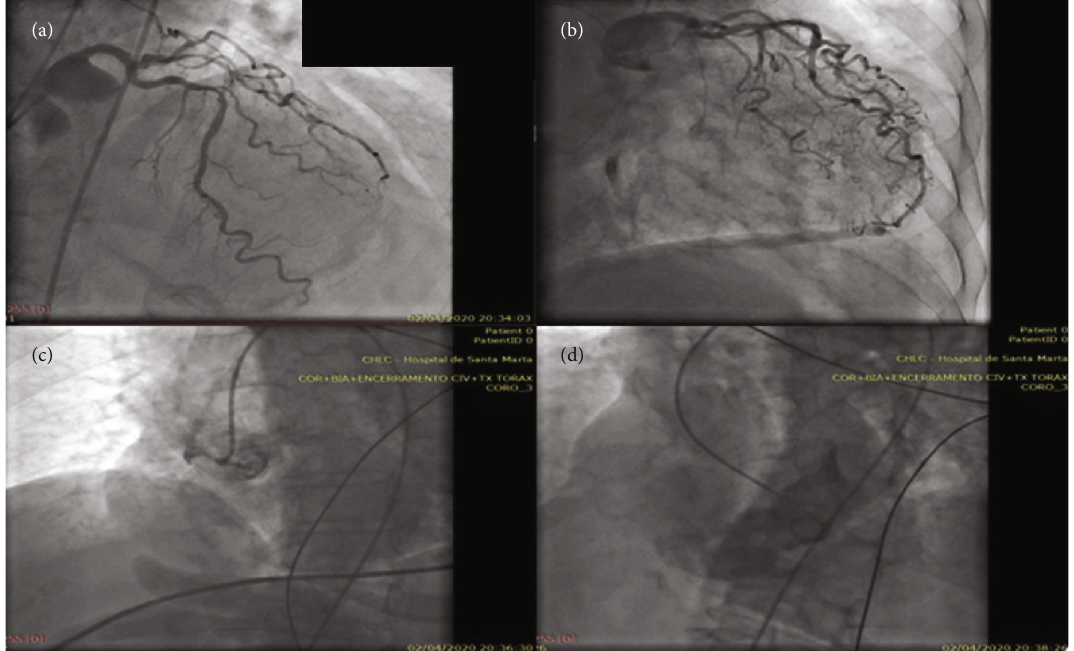
Figure 2: (a) and (b) ICA showing a 50% stenosis of the mid-segment of the LAD and a mid-segment occlusion of the RCA (c). Coronary collaterals are a prognostically important adaptive response in coronary artery disease. Note its absence in (c), which correlate with a larger fi nal infarct volume and an increased risk of mechanical complications. (d) Ventriculography revealing the presence of a LV-to-RV